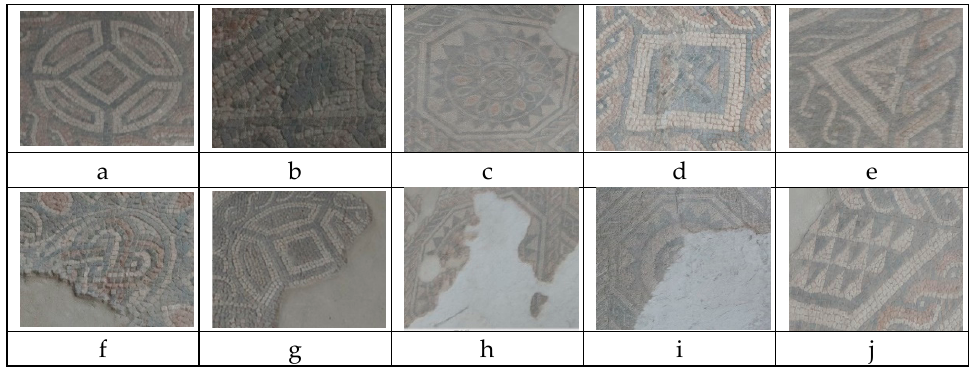
Figure 4. Some image samples of the mosaic forms: ( a ) circle, ( b ) leaf, ( c ) octagon, ( d ) square, ( e ) triangle; incomplete geometric forms from ( f – j ).